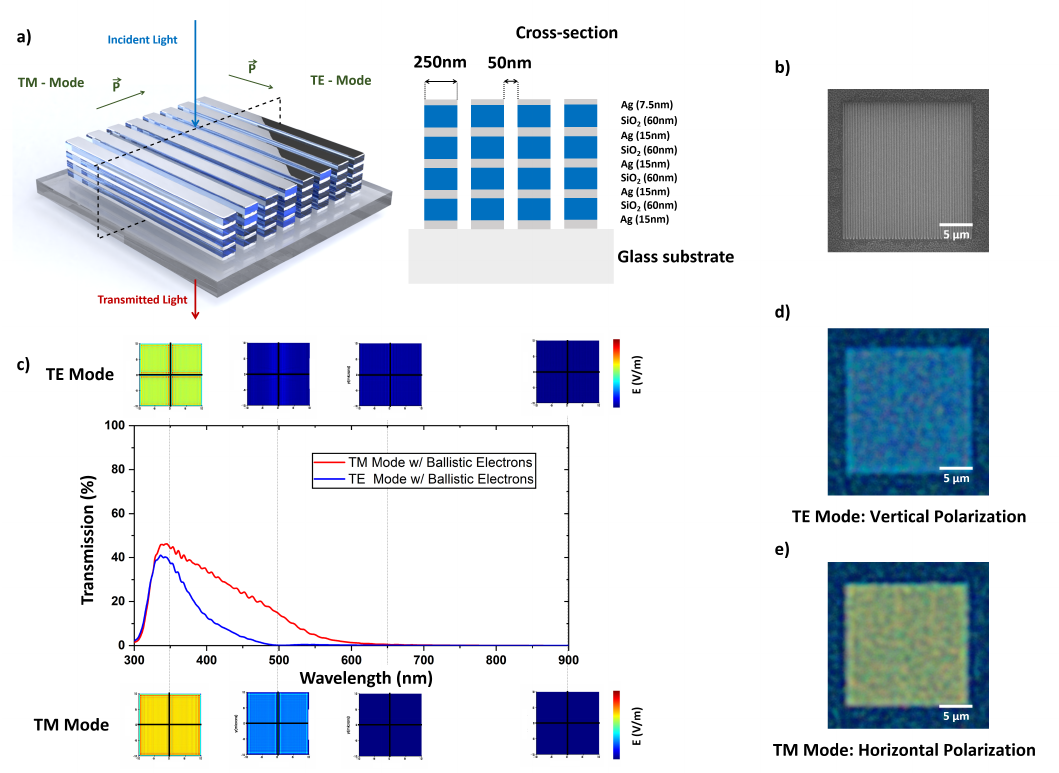
Figure 4: (a) 3D model of a linear array of slits on a metasurface. (b) SEM image of a linear array of slits with 250 nm period and 50 nm width. (c) Simulated normalized transmission spectrum of the metasurface for TE and TM modes and field maps. (d) and (e) are the far-field optical images of the transmitted through the film and the metasurface region as indicated in (b) with the incoming light polarized parallel (TE) to the slits and perpendicular